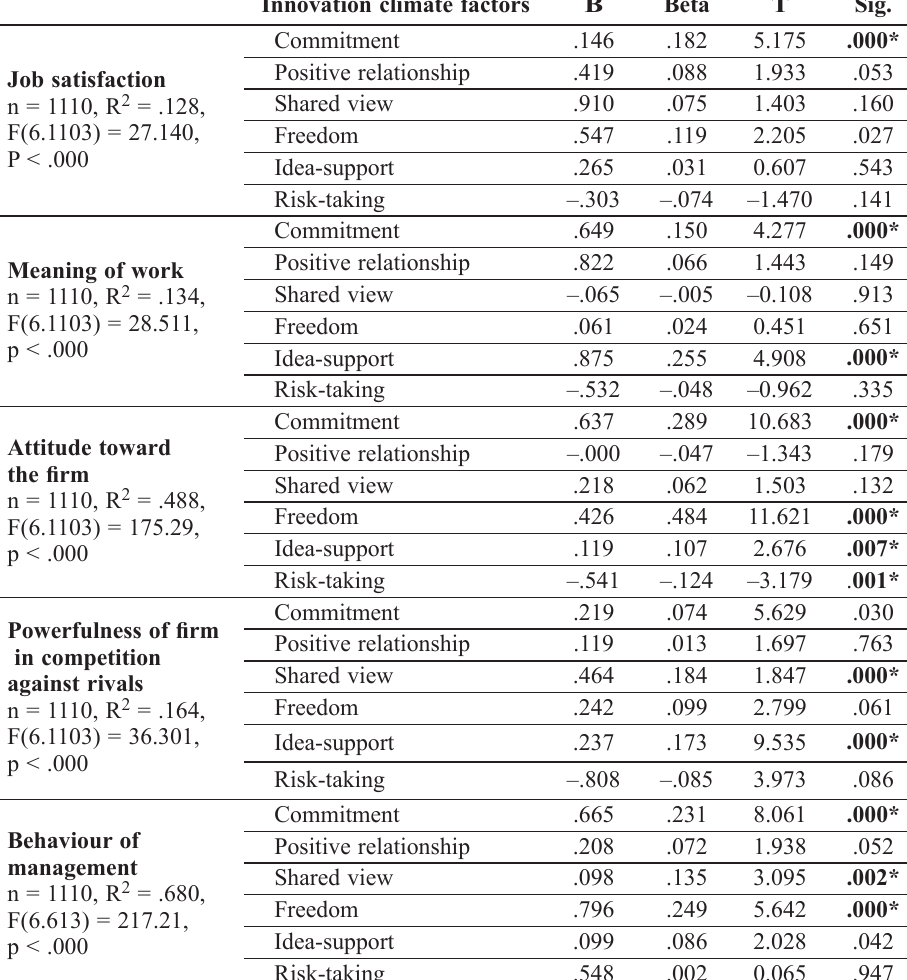
Table 4. Connections between the innovation climate and individual and organisational level factors in Czech Republic (according to standardised regression coefficient Beta) Innovation climate factors